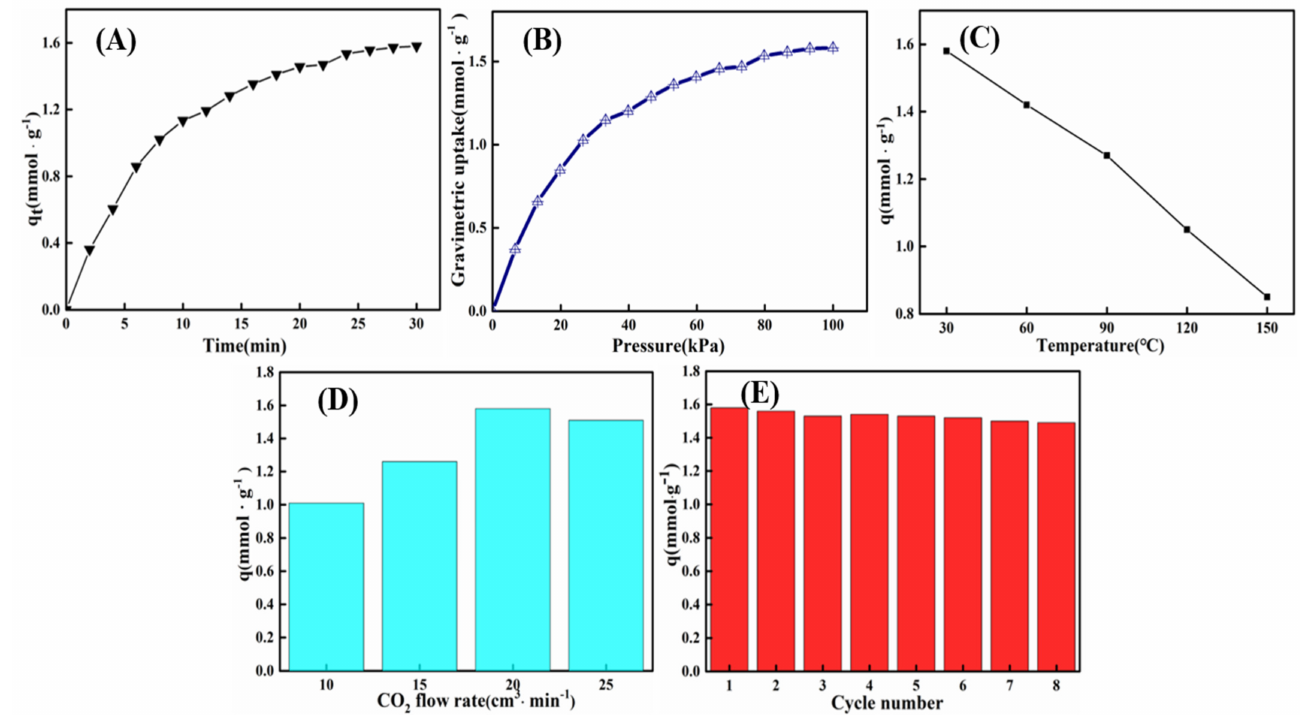
Figure 7. ( A ) Curve of CO 2 adsorption via presented measure; ( B ) curve of gravimetric CO 2 adsorption; ( C ) graph of adsorption capacity at different temperatures; ( D ) column chart of adsorption capacity of materials at different gas flow rates; ( E ) curve of CO 2 adsorption capacity in different cycles of γ -Al 2 O 3 material synthesized at pH = 10 by calcining precipitation of sodium aluminate and hydrochloric acid at 500 ◦